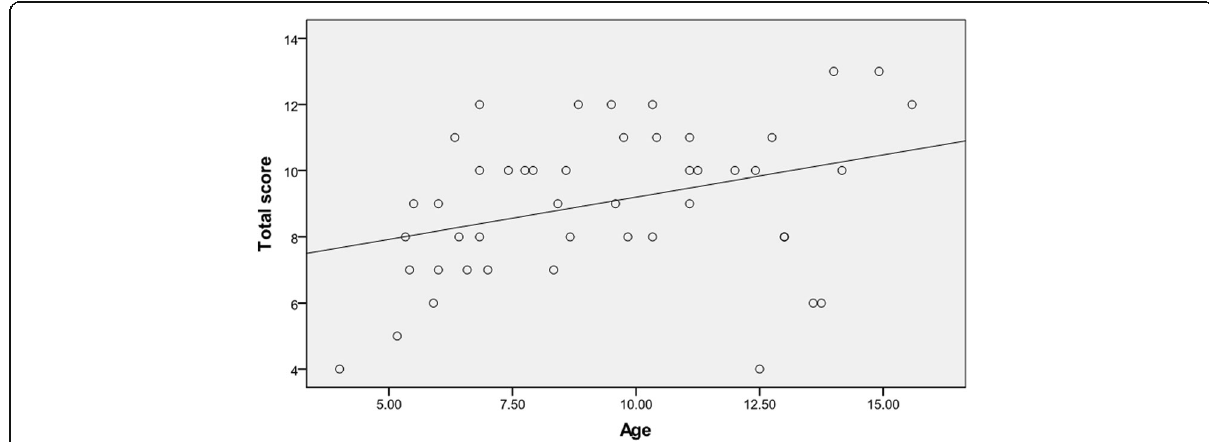
Fig. 4 A linear correlation between age and total score: there was a trend towards increased total score in older children. Older children had a higher total score, indicating that the severity of the clinical phenotype was